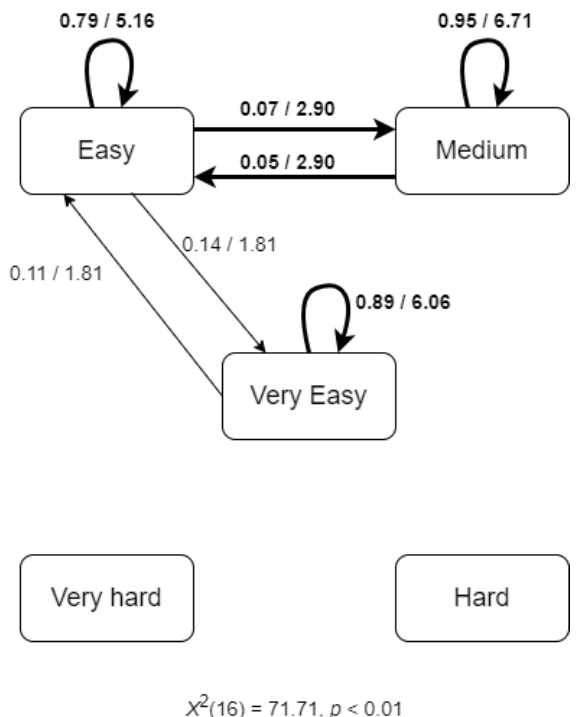
Figure 3. This figure shows the sequential problem-solving behavior of stag hunters in terms of difficulty of problem solved. Stag hunters avoid hard and very hard problems.